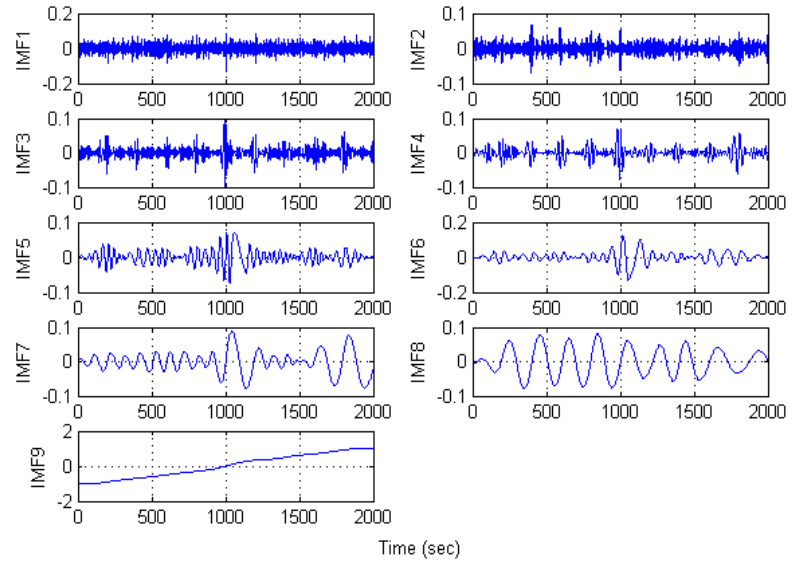
Figure 7. IMFs obtained by the rotation signal decomposition of EMD.